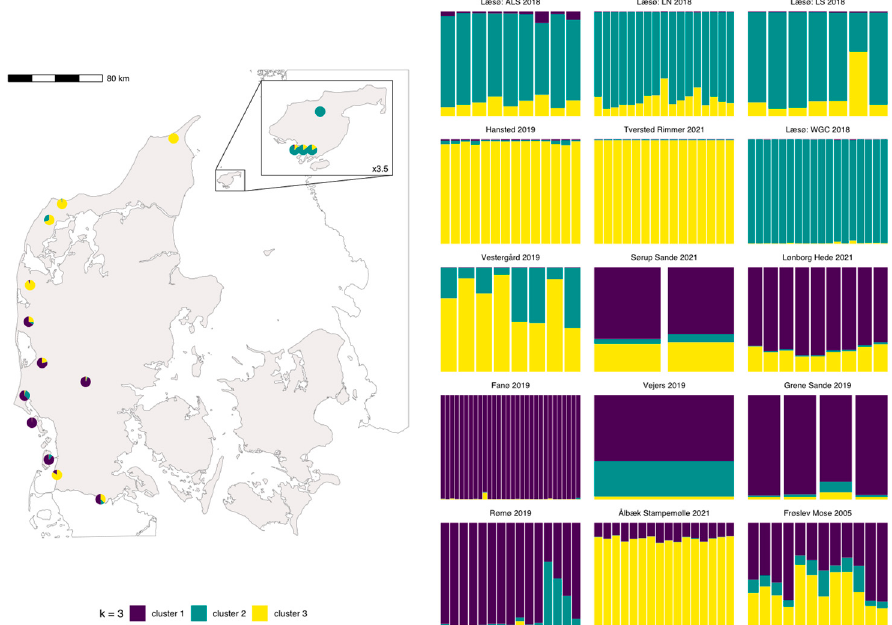
Figure 3. Results of genetic clustering analysis of the contemporary dataset in Structure for k = 3. The dataset included 12 loci. The bar plots show an individual’s probability of belonging to each of the three clusters and the pie charts on the map show the means of all individuals of each population.